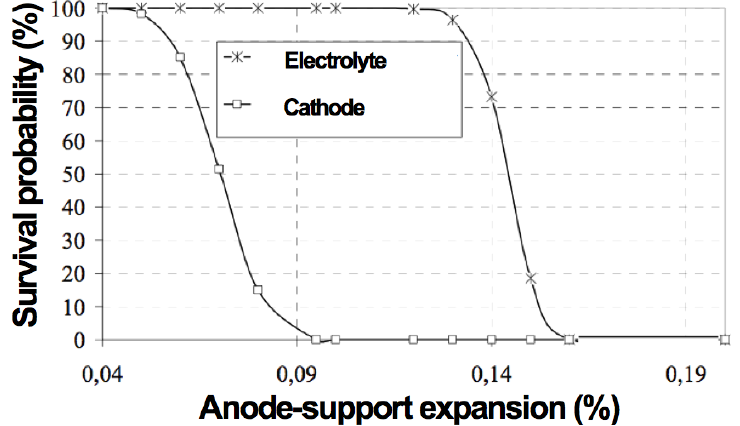
Figure 13. Survival probability of LaSrMn-oxide (LSM) cathode (60 µm) and YSZ electrolyte (10 µm) against the strain of the Ni-YSZ anode support (1 mm)